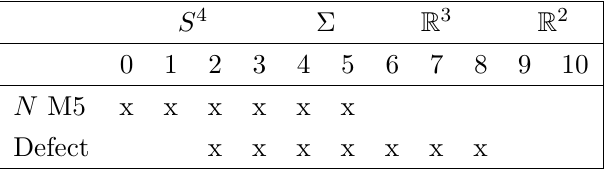
Table 4. Generalized AGT